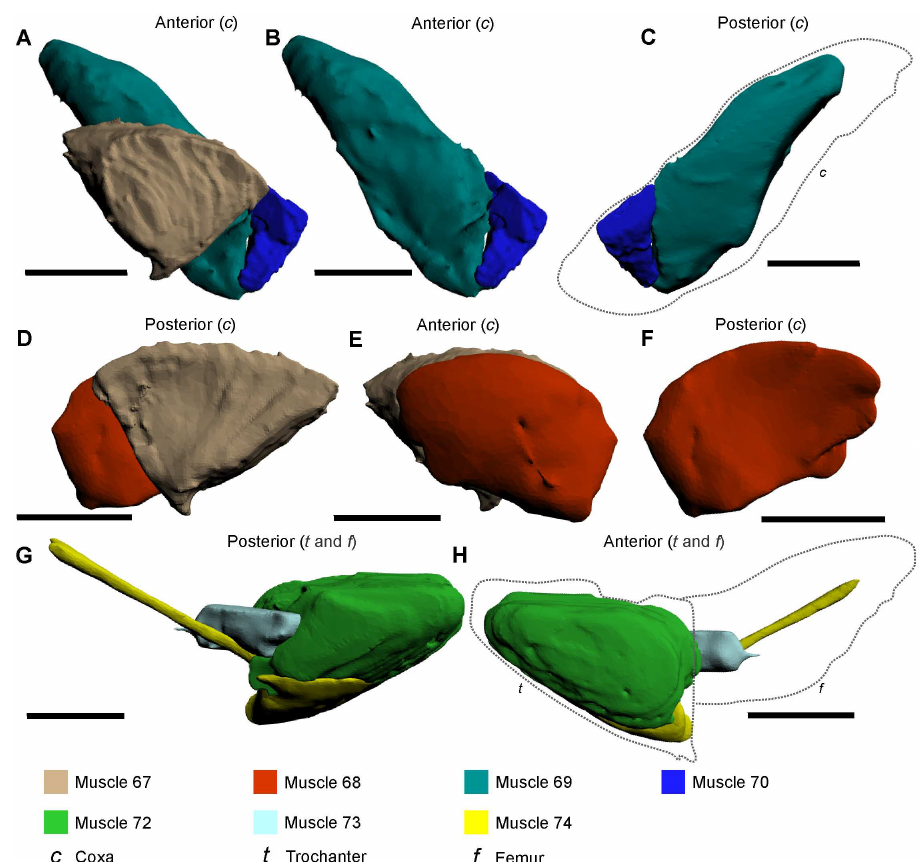
selected from the male pedipalp 3D PDF (S4 Fig), and G–H were selected from the pushing leg PDF (S5 Fig), as these are considered to be the most anatomically informative. The muscles are depicted in anterior and posterior views to accurately display the main features and shapes, as well as positions relative to neighbouring muscles. The dotted line in C outlines the relative position of the coxal segment. The dotted lines in H outline the trochanter and femur. All scale bars 10